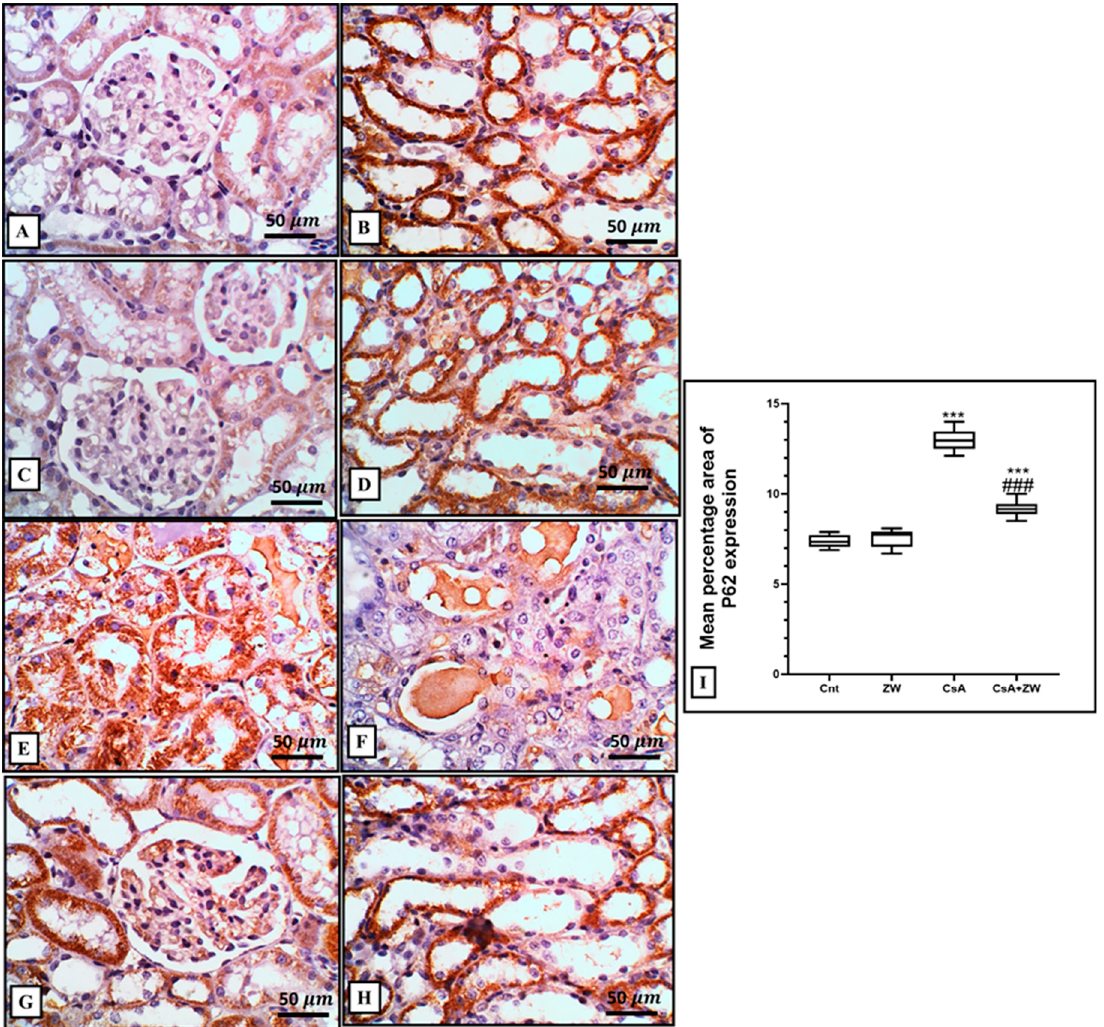
Figure 10. Representative immunohistochemical analysis of P62 expression and localization in the kidney. ( A – D ) The control and ZW groups show few faint cytoplasmic expressions in the cortical tubules without glomerular expression and di ff use expression in the cytoplasm of the medullary tubules. ( E , F ) The CsA group shows di ff use strong expression in the cytoplasm of the necrotic and vacuolated cortical, with lower expression in the medullary tubular cells (intraluminal sloughed cells and intraluminal cast). ( G , H ) The CsA + ZW group shows di ff use cortical and medullary tubular expression with glomerular expression. ( I ) Histogram of the percentage area of the immunostaining of renal P62. *** p < 0.001 vs. control ; ### p < 0.001 vs. CsA. Image magni fi cation = 400×; scale bar = 50 µm.